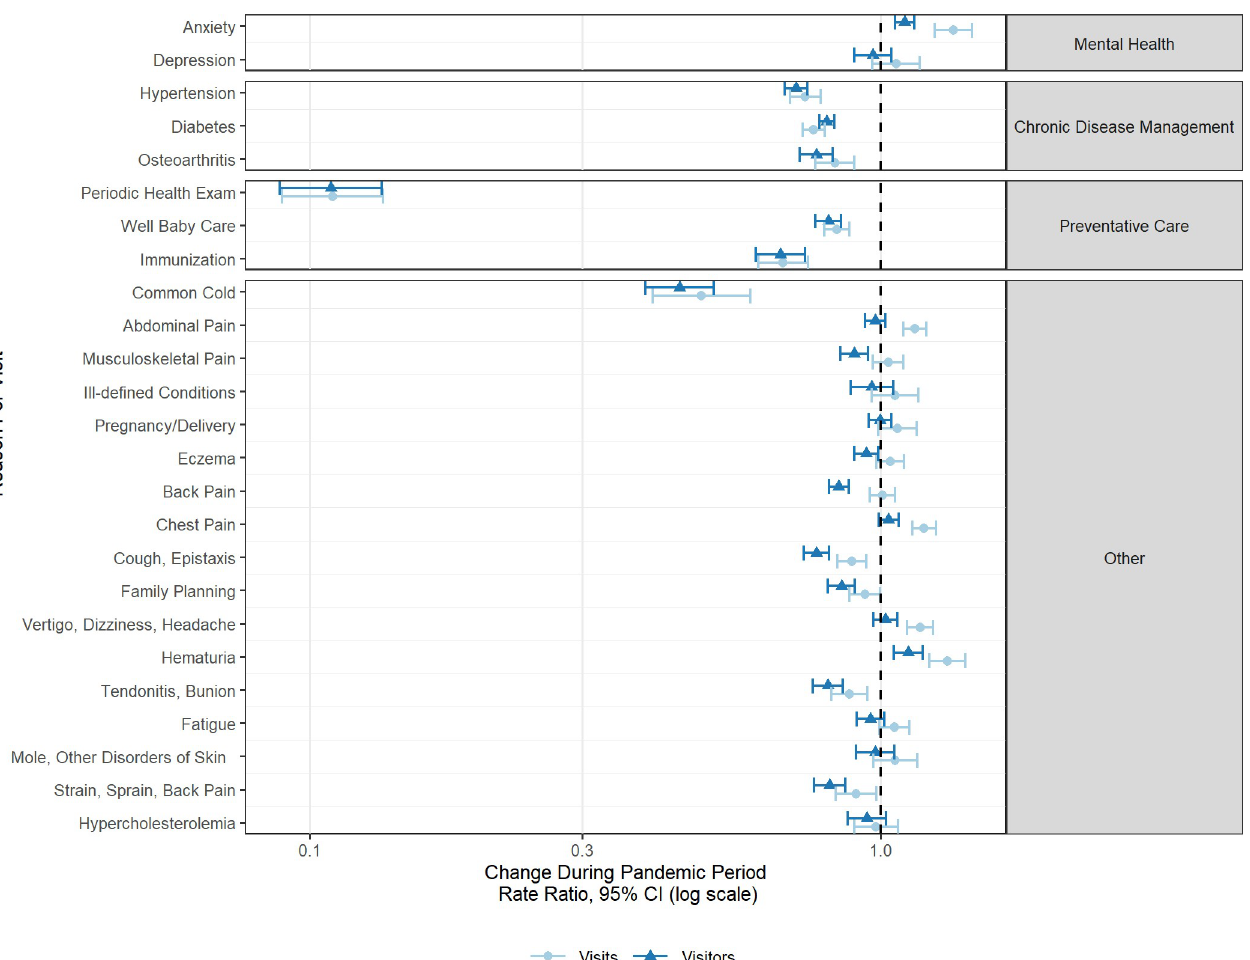
Fig 2. Change in visit and visitor volume by reason for visit during the COVID-19 pandemic. When the rate ratio for visits in larger than the rate ratio for visitors (i.e., interval is further to the right), this indicates that the intensity of visits per visitor increased during the pandemic. When the rate ratio for visits in smaller than the rate ratio for visitors (i.e., interval is further to the left), this indicates that the intensity of visits per visitor decreased during the